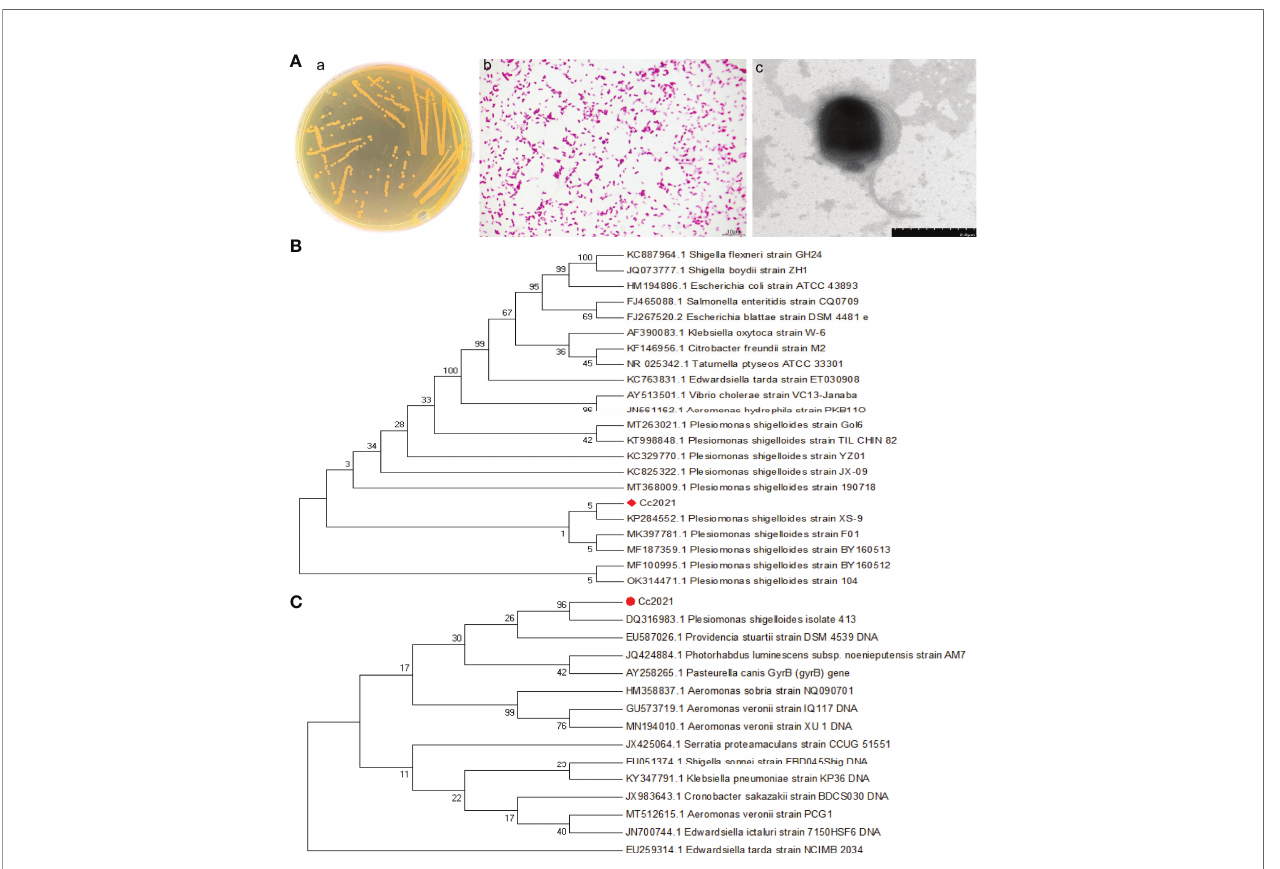
FIGURE 2 | Identi fi cation of the pathogen ’ s morphological and molecular characteristics. (A) (a) Growth characteristics of isolates in BHI medium. (b) Gram staining results of isolates. (c) Negative staining results of isolates. (B) Phylogenetic tree based on the partial 16S rRNA gene sequences included in the expanded MicroSeq 500 library; the algorithm used to construct the tree was the unweighted pair group method using averages (UPGMA). (C) Phylogenetic tree based on the partial gyrB gene sequences included in the expanded MicroSeq 500 library; the algorithm used to construct the tree was UPGMA.